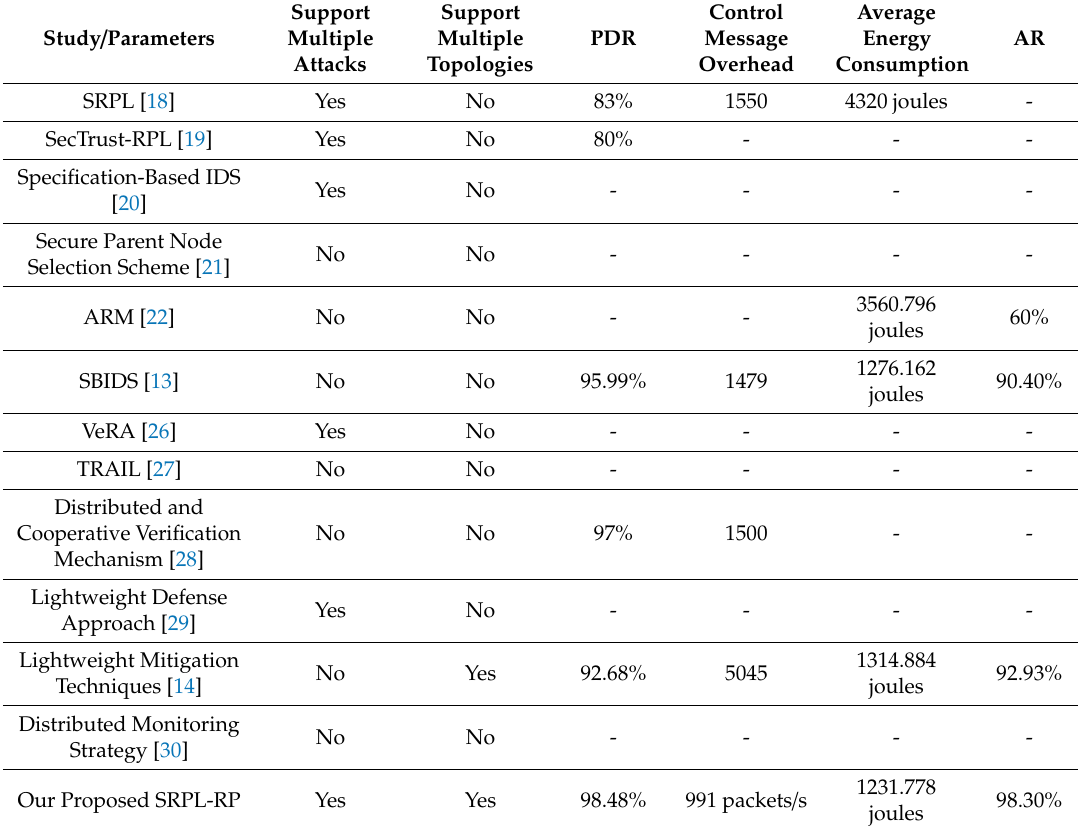
Table 15. Comparison among Studies in Literature Review and our Proposed